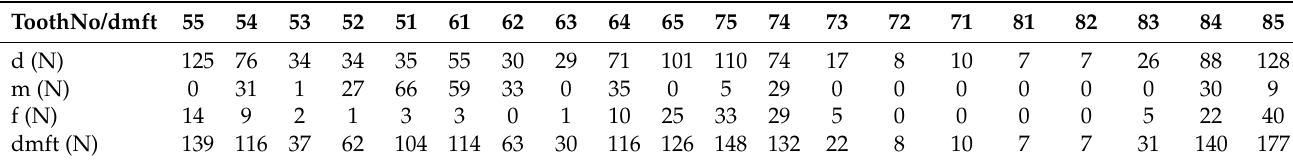
Table 2. The details of dmft scores based on tooth type.